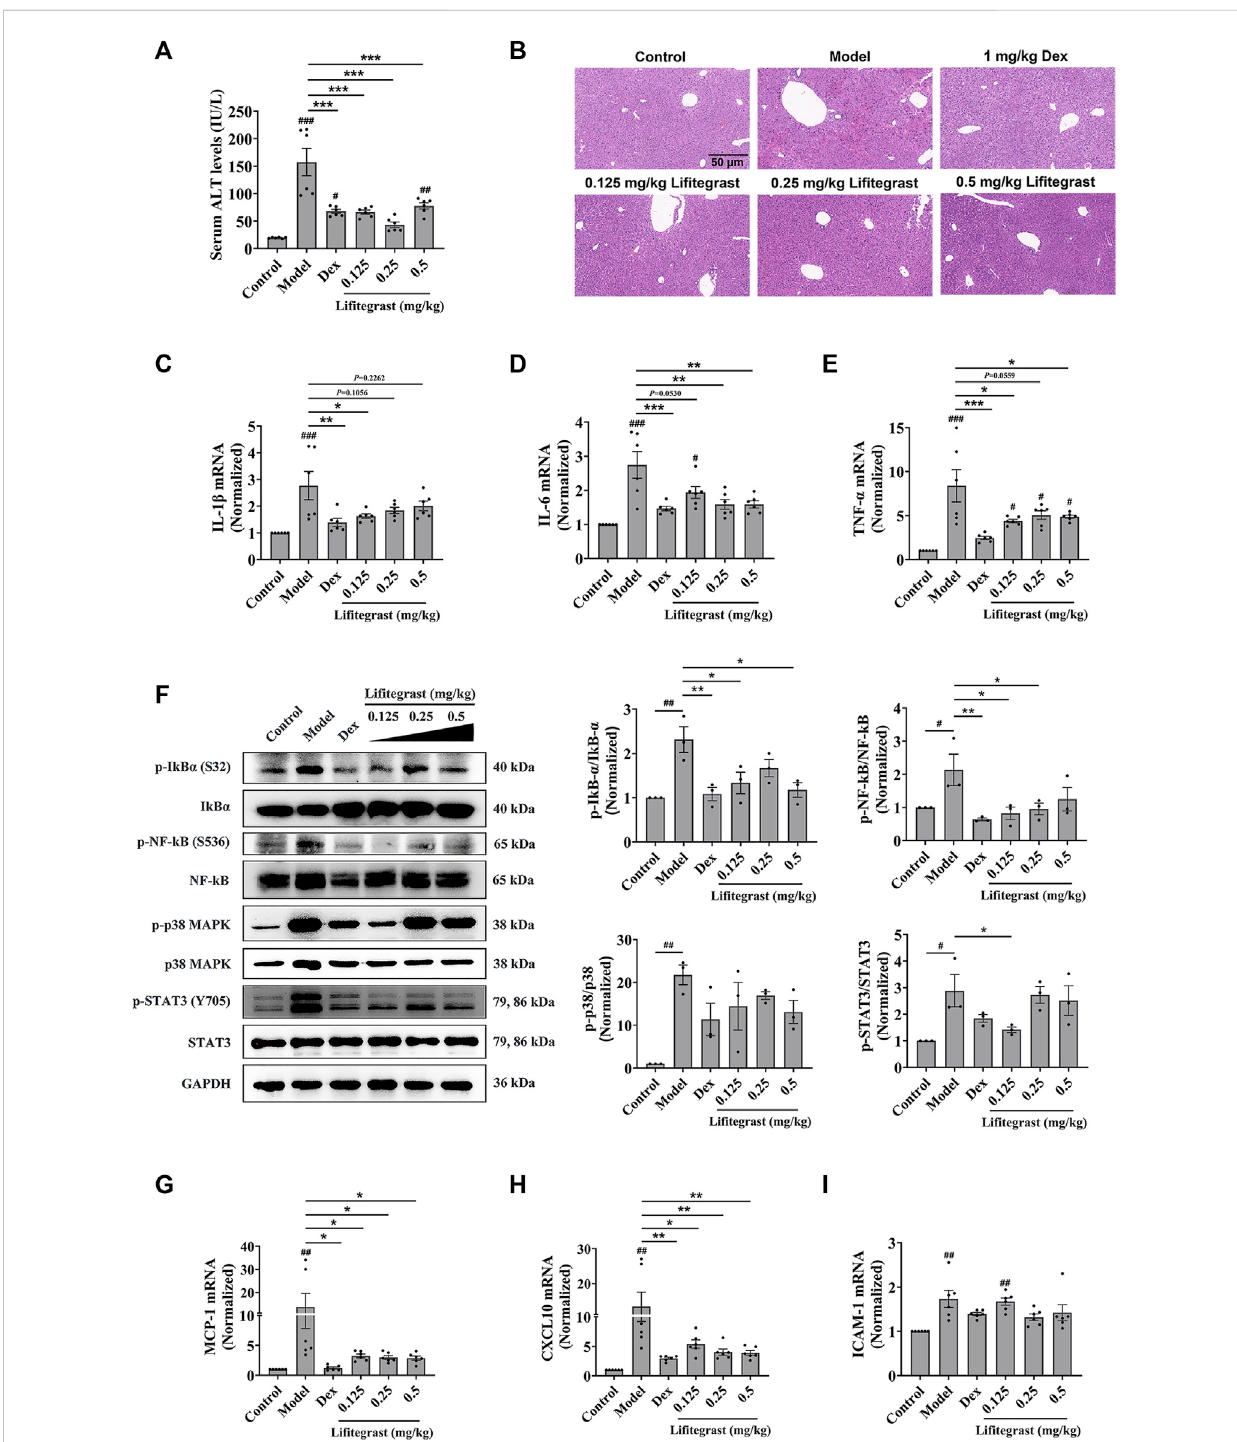
FIGURE 4 Li fi tegrast ameliorates mouse acute liver injury induced by Poly(I:C)/D-GalN. (A) ALT level in serum, n = 6. (B) Liver H&E staining, the scale bar was 50 µm. (C – E) ThemRNAlevelsofIL-1 β (C) ,IL-6 (D) ,andTNF- α (E) intheliver, n =6. (F) Thephosphorylationlevelsofin fl ammatoryfactorsintheliver, n = 3. (G – I) The mRNA levels of MCP-1 (G) , CXCL10 (H) , and ICAM-1 (I) in the liver, n = 6. Data were presented as mean ± SEM. # p < 0.05, ## p < 0.01, ### p < 0.001 vs. Control, and * p < 0.05, ** p < 0.01, *** p < 0.001 vs.